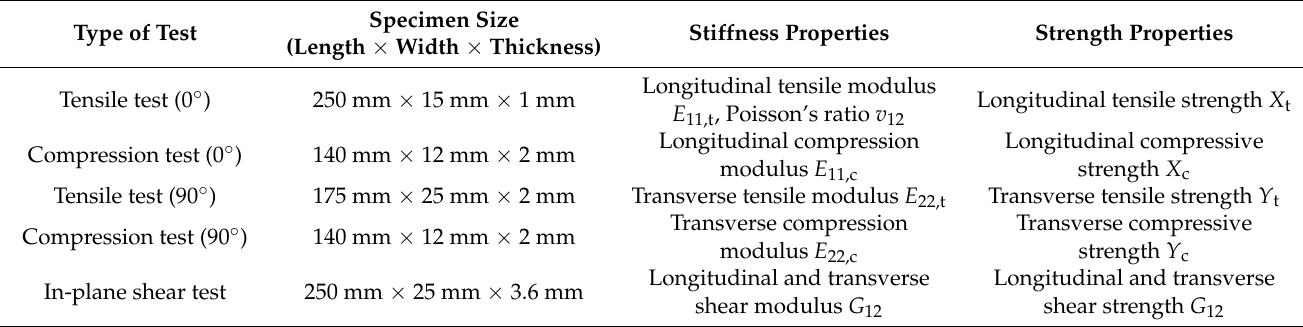
Table 2. Tests used to determine the basic mechanical properties.